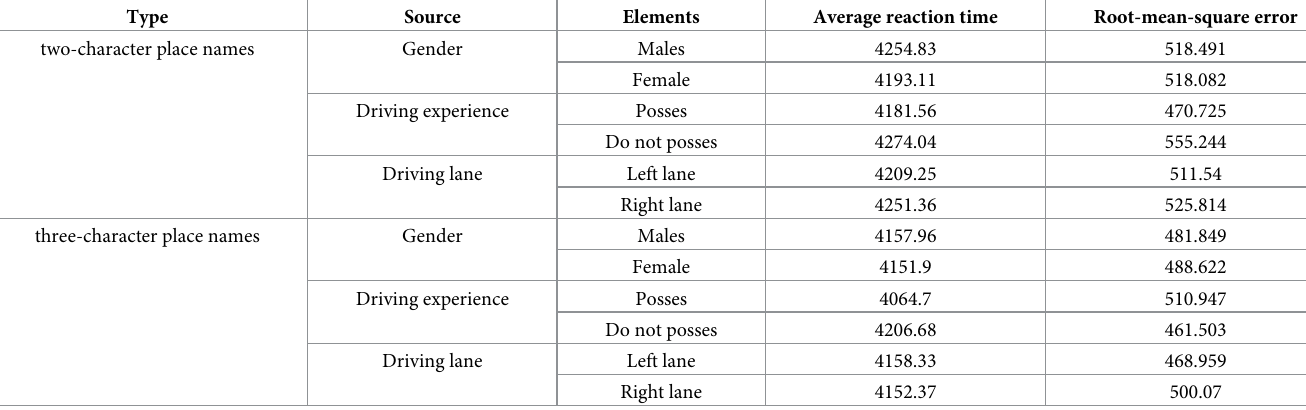
Table 8. Recognition reaction time of exit advance guide